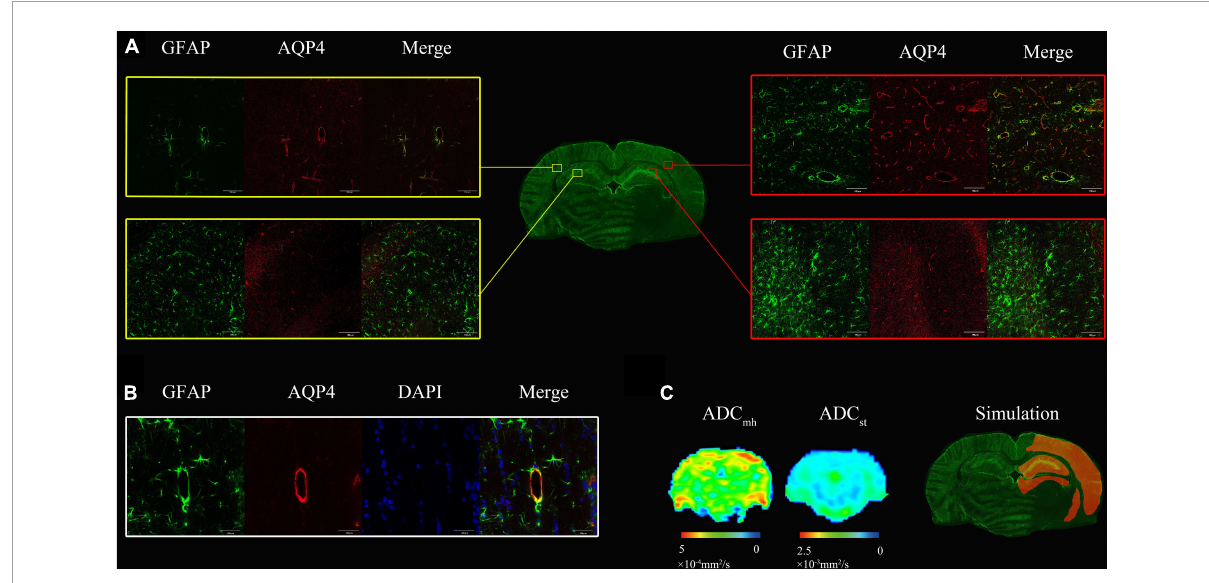
FIGURE4 (A) At 6 h after MACO, there was an extensive increase level of both Aquaporin 4 (AQP4) (red) and GFAP (green) in the ipsilateral cerebral cortex and hippocampus compared with the contralateral side. (B) The AQP4 colocalized with the GFAP staining surrounding blood vessels. (C) There were localized increased multi-high b -value ADCs (ADC mh ) value in the ipsilateral cerebral cortex, but no visible change on the ADC map. The last one is the simulation diagram of regions with increased AQP4 expression that is highlighted in orange, which was much more extensive than the hyperintensity of ADC mh